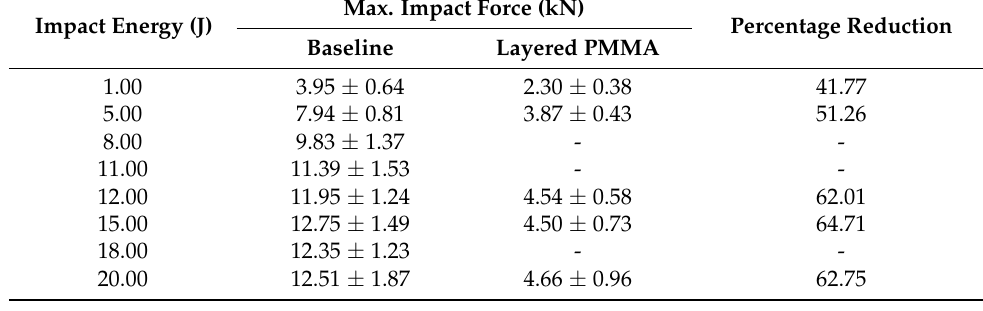
Figure 5. Variations of the maximum impact force for both baseline and layered PMMA specimens as a function of impact energy.